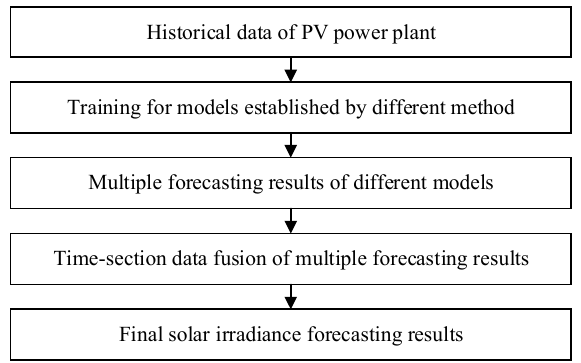
Figure 1. The framework of day-ahead solar irradiance ensemble forecasting.